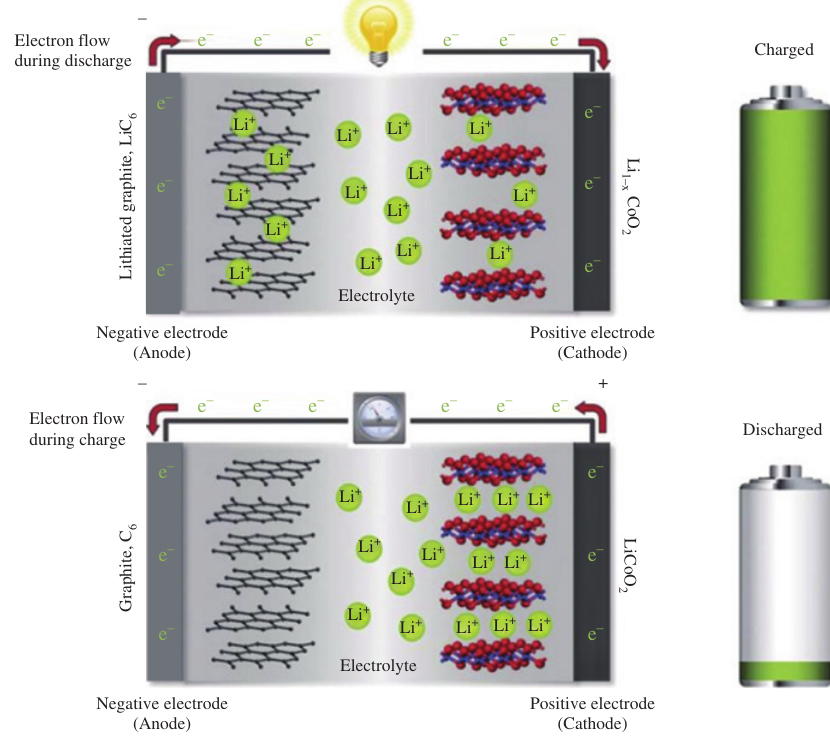
Figure 2: Schematic view of the principle of operation of a lithium-ion cell. Reprinted from